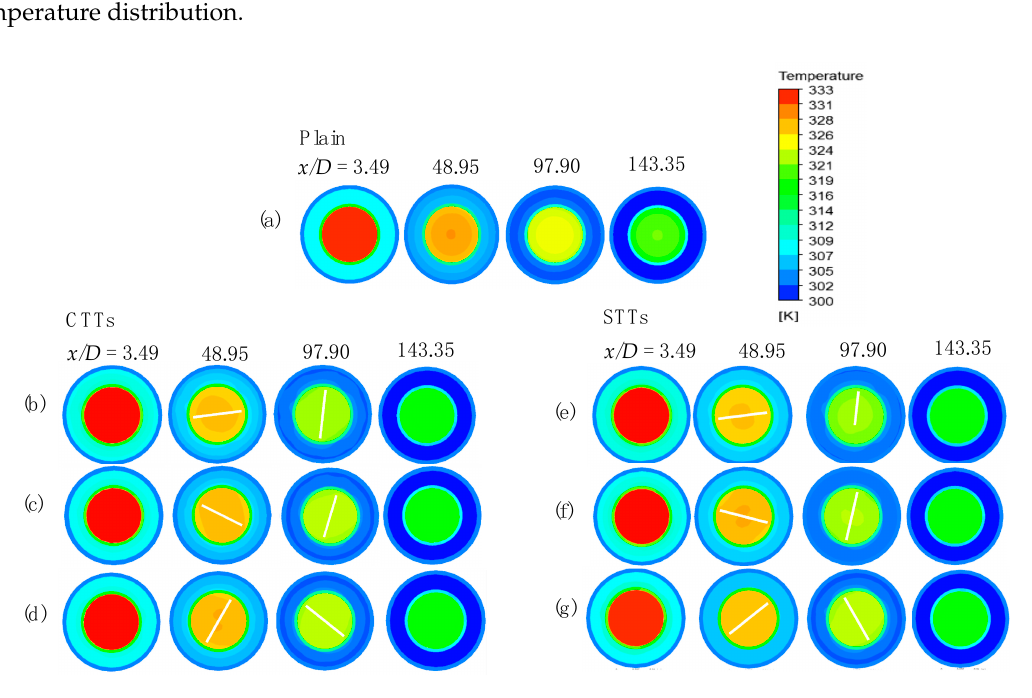
Figure 5. Contour plots of temperature at axial locations x / D of 3.49, 48.95, 97.90, and 143.35 at Re = 14,100 for ( a ) PT, ( b ) y / W = 2.7 CTT, ( c ) y / W = 4.5 CTT, ( d ) y / W = 6.5 CTT, ( e ) y / W = 2.7 STT, ( f ) y / W = 4.5 STT, and ( g ) y / W = 6.5 STT.